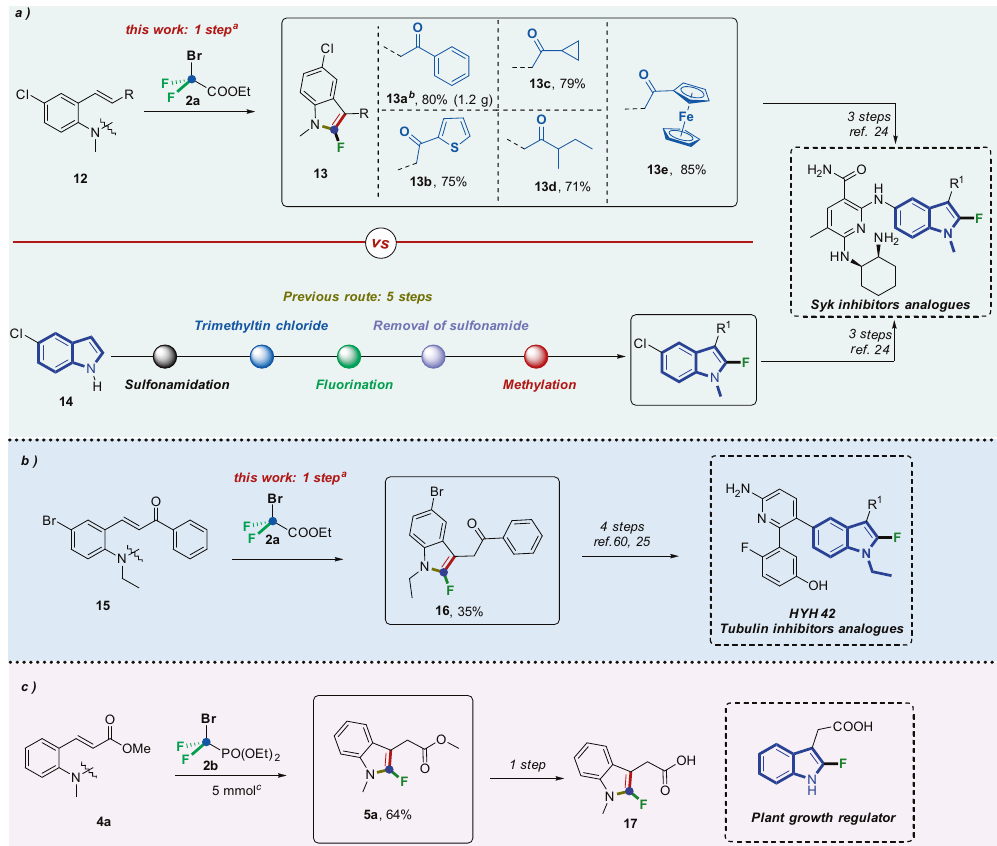
Fig. 6 Synthetic applications. Reaction conditions: a 12 or 15 (0.2 mmol), 2a (3 equiv., 0.6 mmol), K 3 PO 4 (3 equiv.), H 2 O (0.1 mL), CH 3 CN (2 mL) under 90 °C for 12 h, N 2 . b 12a (5 mmol), 2a (3 equiv., 15 mmol), K 3 PO 4 (3 equiv.), H 2 O (1.5 mL), CH 3 CN (25 mL) under 90 °C for 24 h, N 2 . c 4a (5 mmol), 2b (3 equiv., 15 mmol), K 2 CO 3 (3 equiv.), H 2 O (1.5 mL), CH 3 CN (25 mL) under 90 °C for 24 h, N 2 .